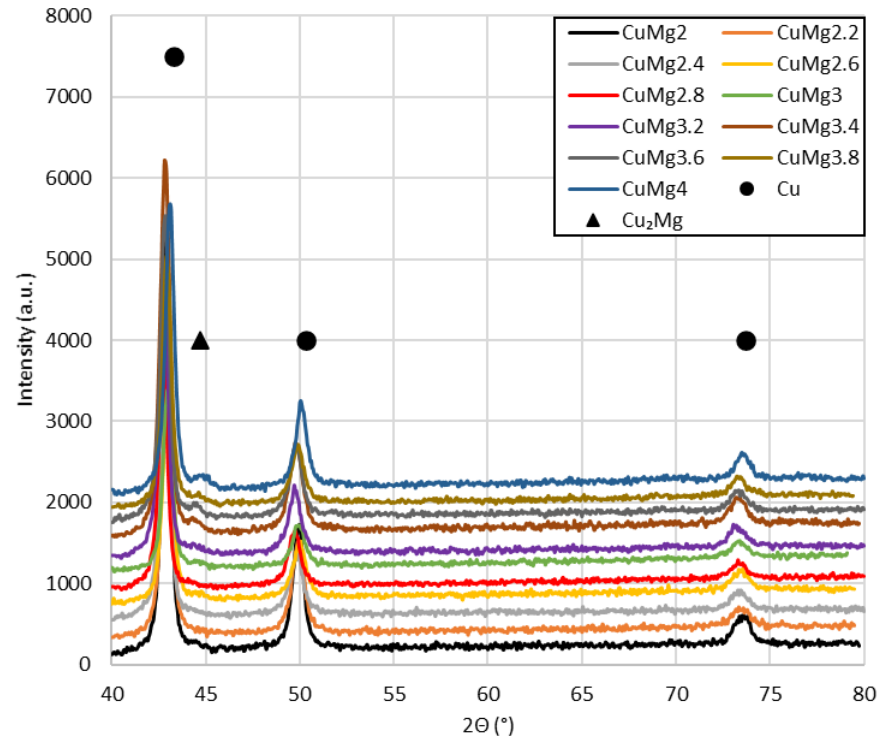
Figure 7. The X-ray diffraction patterns for the CuMg ingots obtained with pure Mg in the as-cast state with the marked peaks.